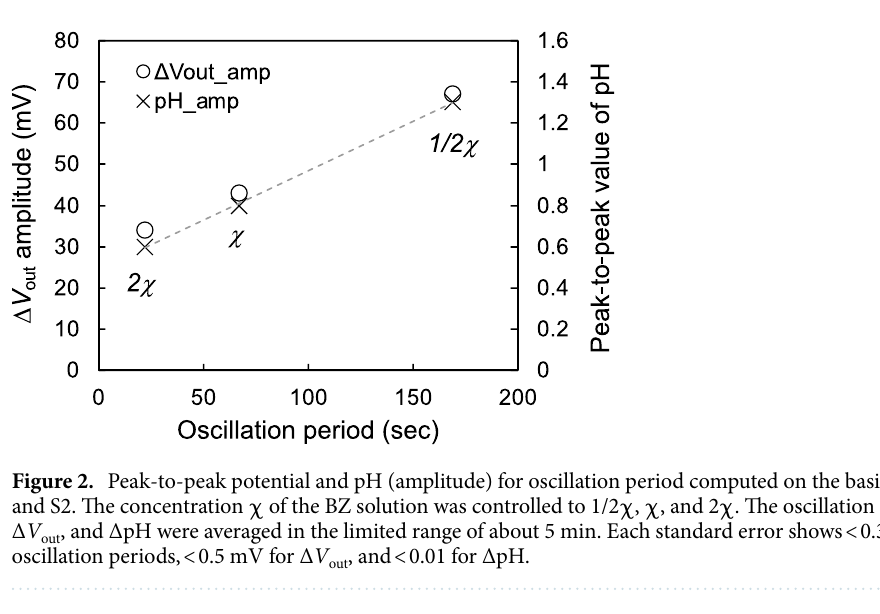
Figure 1. Change in interfacial potential (Δ V out ) for BZ reaction detected using single-gate ISFET sensor. Malonic acid was added to the BZ presolution without malonic acid (pH 1.0). Δ V out was translated to pH in accordance with the pH sensitivity of the ISFET sensor (i.e., the Nernstian response) used in this study (Fig. S1).